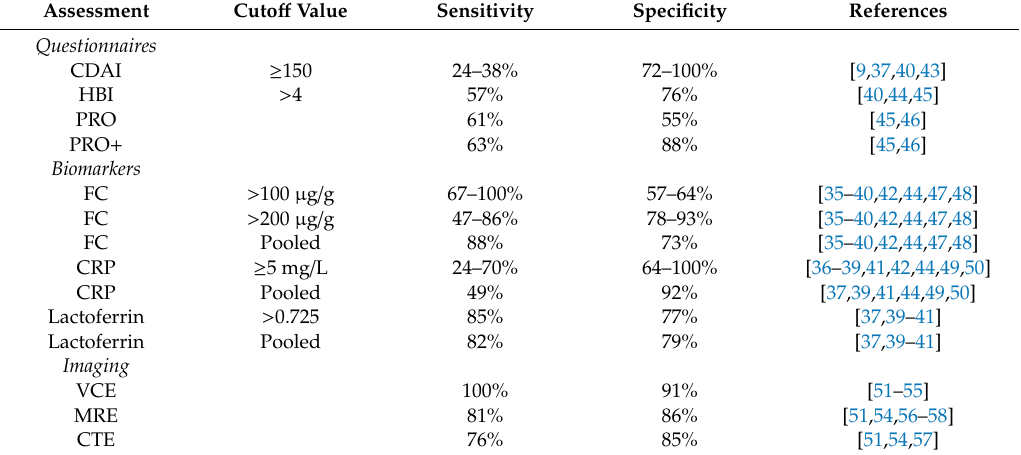
Table 2. Predictors of endoscopic disease